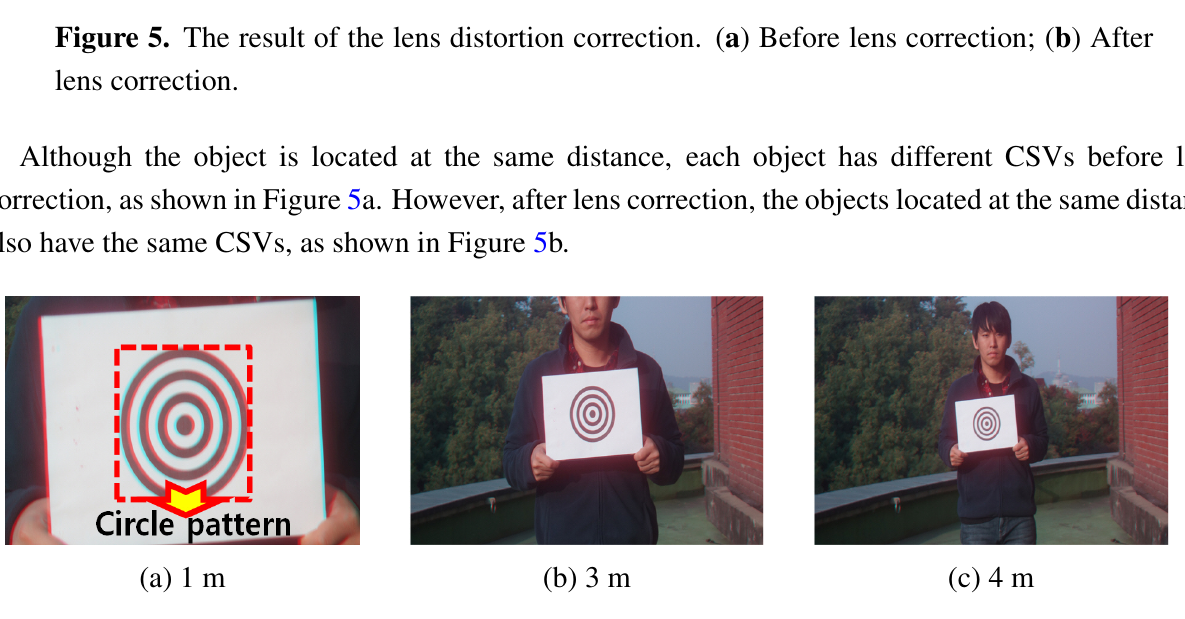
Figure 6. A concentric circle pattern for calibrating DCA parameters. ( a ) 1 m; ( b ) 3 m; ( c ) 4